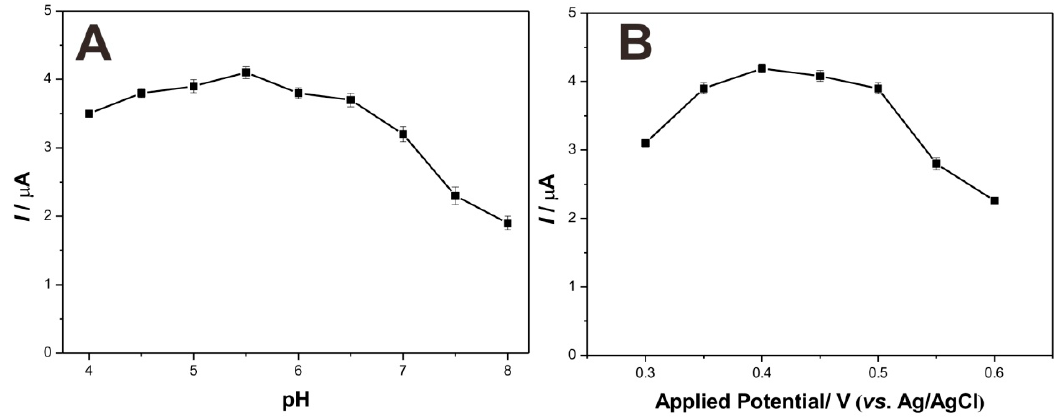
Figure 6. The effects of pH ( A ) and applied potentials ( B ) of GCE/Lac-PdBC-Nafion on the catalytic currents of dopamine in 0.1 M PBS containing 100 µM dopamine.